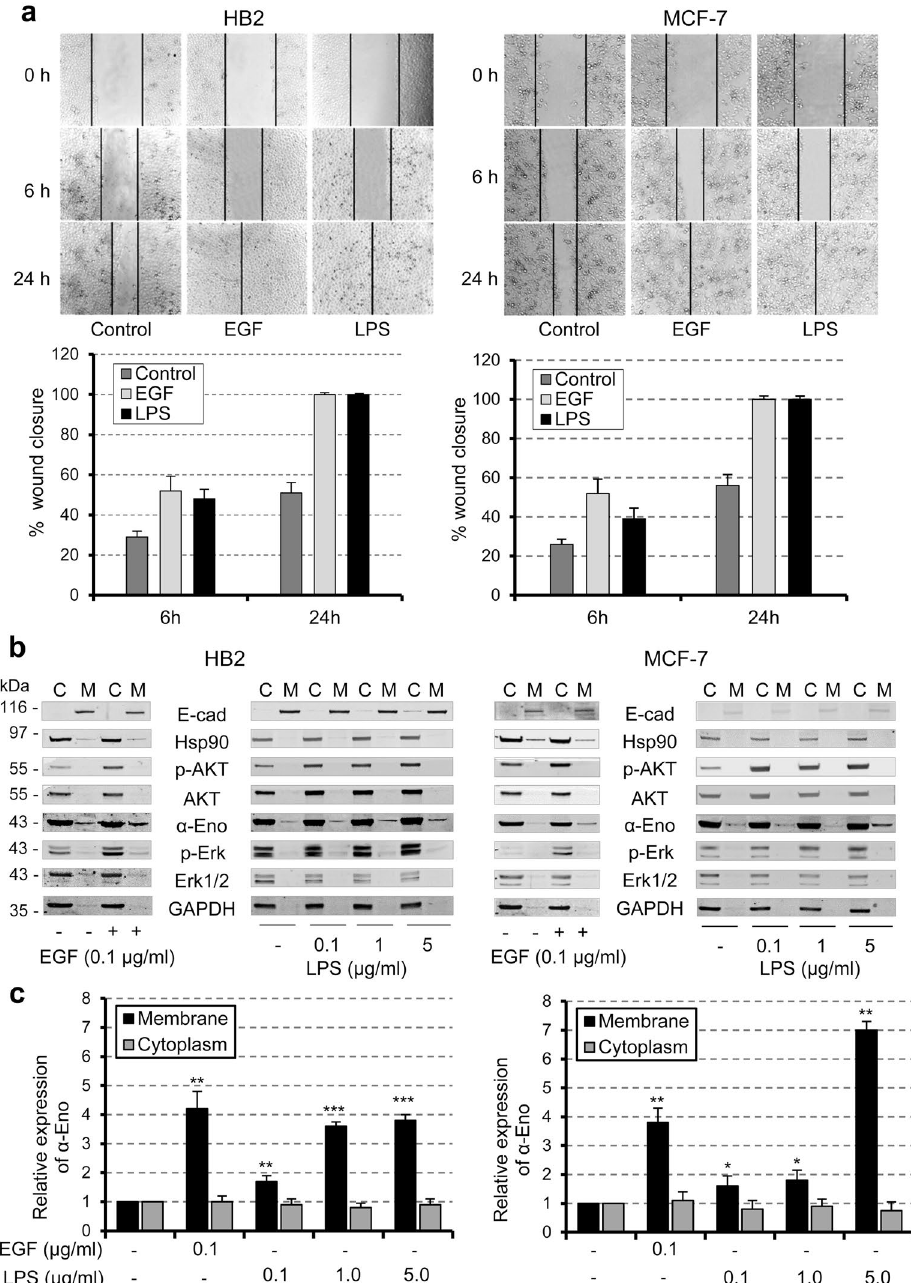
Figure 1. EGF and LPS promote cell migration and the up-regulation of alpha-enolase in the membrane fraction of non-tumourigenic and cancer cells. ( a ) A wound-healing assay was performed to observe changes in the migratory ability of non-tumourigenic HB2 and low metastatic MCF-7 cells after stimulation with 0.1 µ g/ ml of either EGF or LPS for the indicated length of time. Migration at the edge of the scratch was analysed at 0, 6 and 24 hours, when microscopy images were captured (magnification, 100x, top panel). Cell motility was quantified by measuring the scratch wound, and results are expressed relative to total closure (100%). Each bar represents the mean ± standard deviation of three independent experiments (lower panel). ( b ) HB2 and MCF-7 cells were treated with the indicated EGF or LPS concentrations for 24 hours, after fractionation cell equivalents of cytoplasmic (C) and total membrane (M) fractions were separated by SDS-PAGE and analysed by immunoblotting. E-cadherin (E-cad) and Hsp90 were used to estimate proper fractionation, pAKT and pERK to confirm the effectiveness of treatments. Changes in alpha-enolase ( α -Eno) expression levels were analysed in treated versus untreated ( − ) cells, and GAPDH was used as a further control. ( c ) Quantification of alpha- enolase in cytoplasmic and total membrane fractions. Data were normalised to the densitometric signals of Ponceau staining (see Supplementary Fig. 1) and expressed relative to the untreated control, set at 1. Each data point is the average of three independent experiments, error bars represent standard deviation and p values ( * P < 0.05, ** P < 0.01, *** P < 0.001) indicate statistical